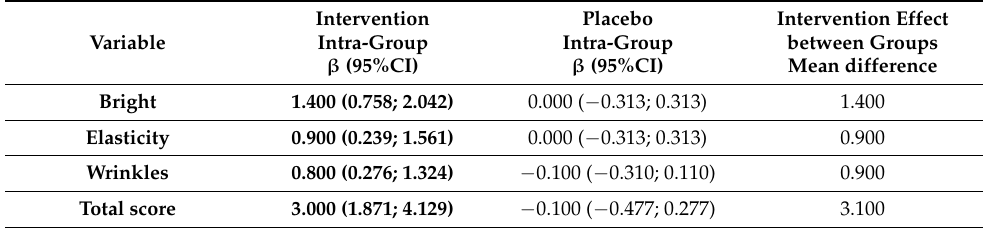
Table 3. Within-group and between-group differences for skin effects for the intervention and placebo groups. The estimate of the effect β , its 95% confidence interval (CI) and the adjusted p -value of the null hypothesis of a null effect are reported.